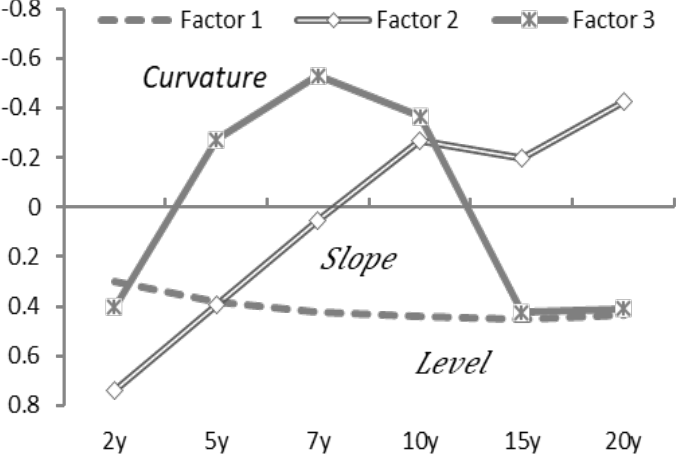
Figure 5. Eigenvectors of the principal component analysis (PCA) factors 1–3.